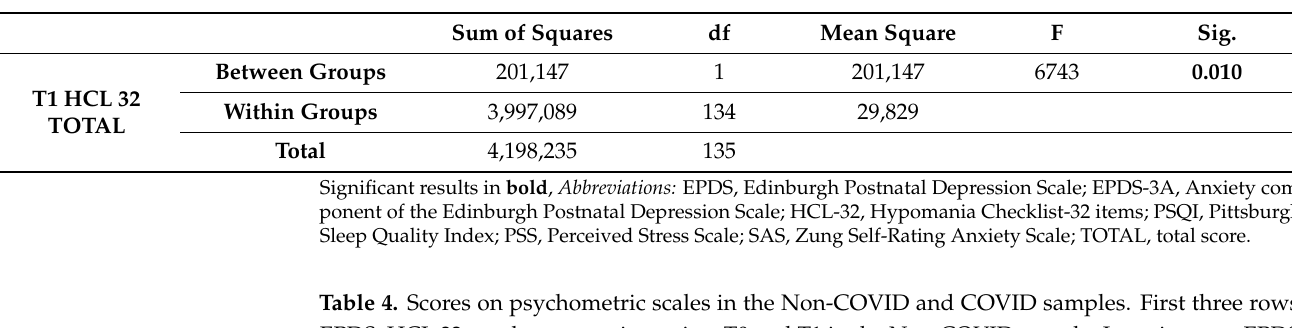
Table 4. Scores on psychometric scales in the Non-COVID and COVID samples. First three rows: EPDS, HCL 32, total scores at timepoints T0 and T1 in the Non-COVID sample. Last six rows: EPDS, HCL 32, PSS, PSQI, and SAS total scores at timepoints T0 and T1 in the COVID sample. Sum of